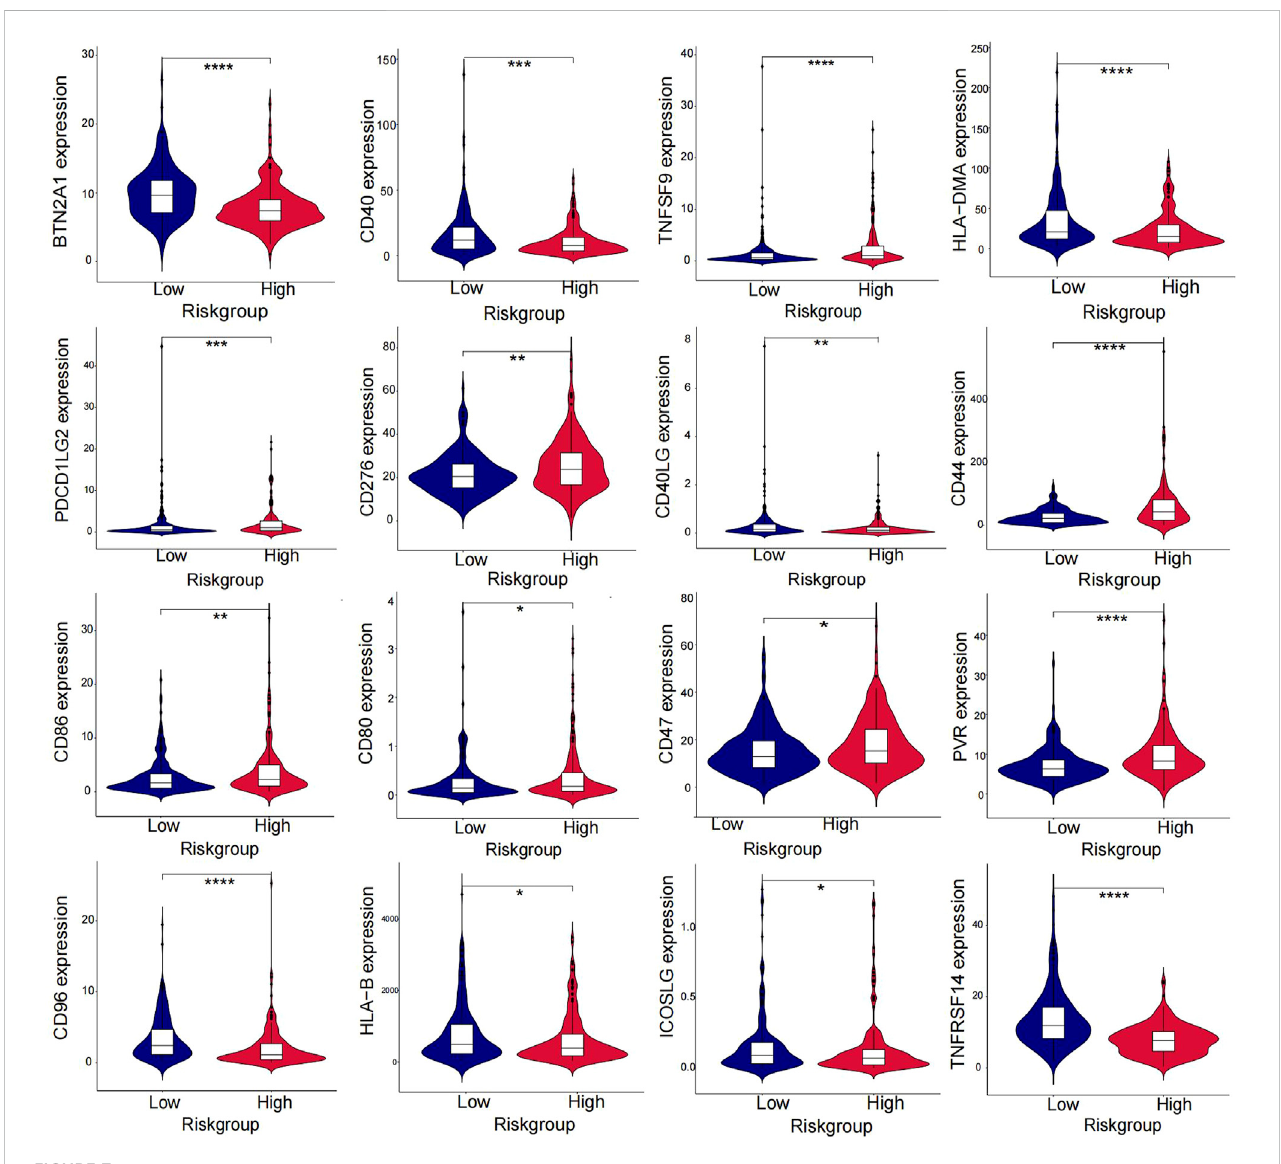
FIGURE 7 Differences in immune checkpoints between high and low-risk